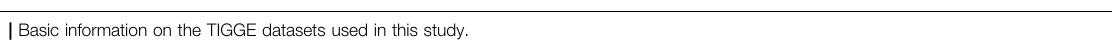
TABLE 1 | Basic information on the TIGGE datasets used in this study. Country Data